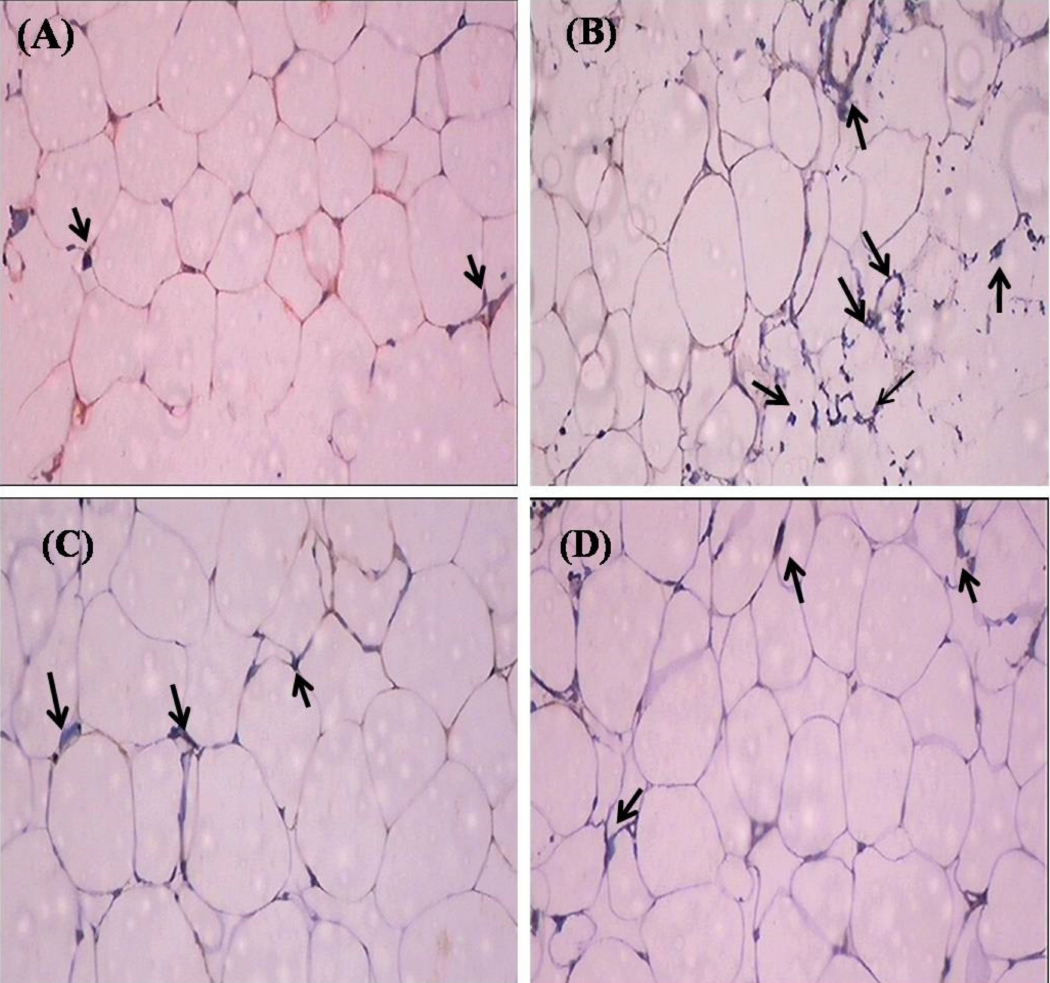
Figure 5. Effect of SIT on TNF- α protein expression in the adipose tissue of type-2 diabetic rats. The adipose tissue samples were dissected out from experimental rats and protein expression of TNF- α was measured by immunohistochemistry (IHC). The representative IHC photomicrographs (100 × magnification) of TNF- α staining intensity (arrows) in the adipose tissue samples of experimental groups are shown in this figure. ( A ) Normal rats; ( B ) type-2 diabetic rats showed elevated expression of TNF- α ; ( C ) type-2 diabetic rat treated with β -sitosterol (20 mg/kg b.wt/day orally for 30 days) showed a considerable decline in the expression of TNF- α when compared with type-2 diabetic rats and ( D ) type-2 diabetic rats treated with metformin (50 mg/kg, b.wt/day orally for 30 days) showed a significant reduction in the TNF- α protein